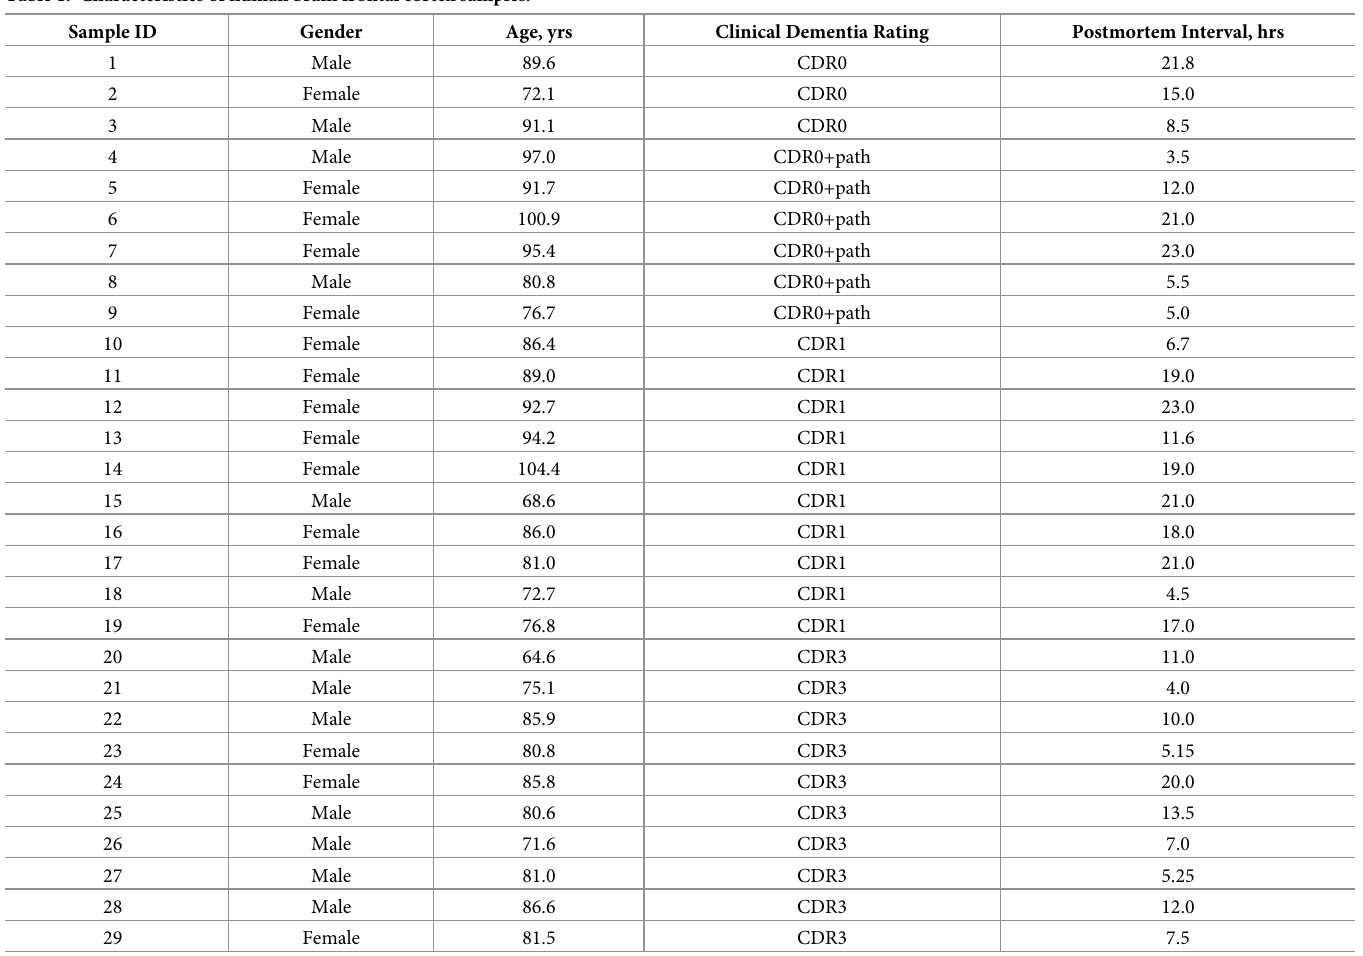
Table 1. Characteristics of human brain frontal cortex